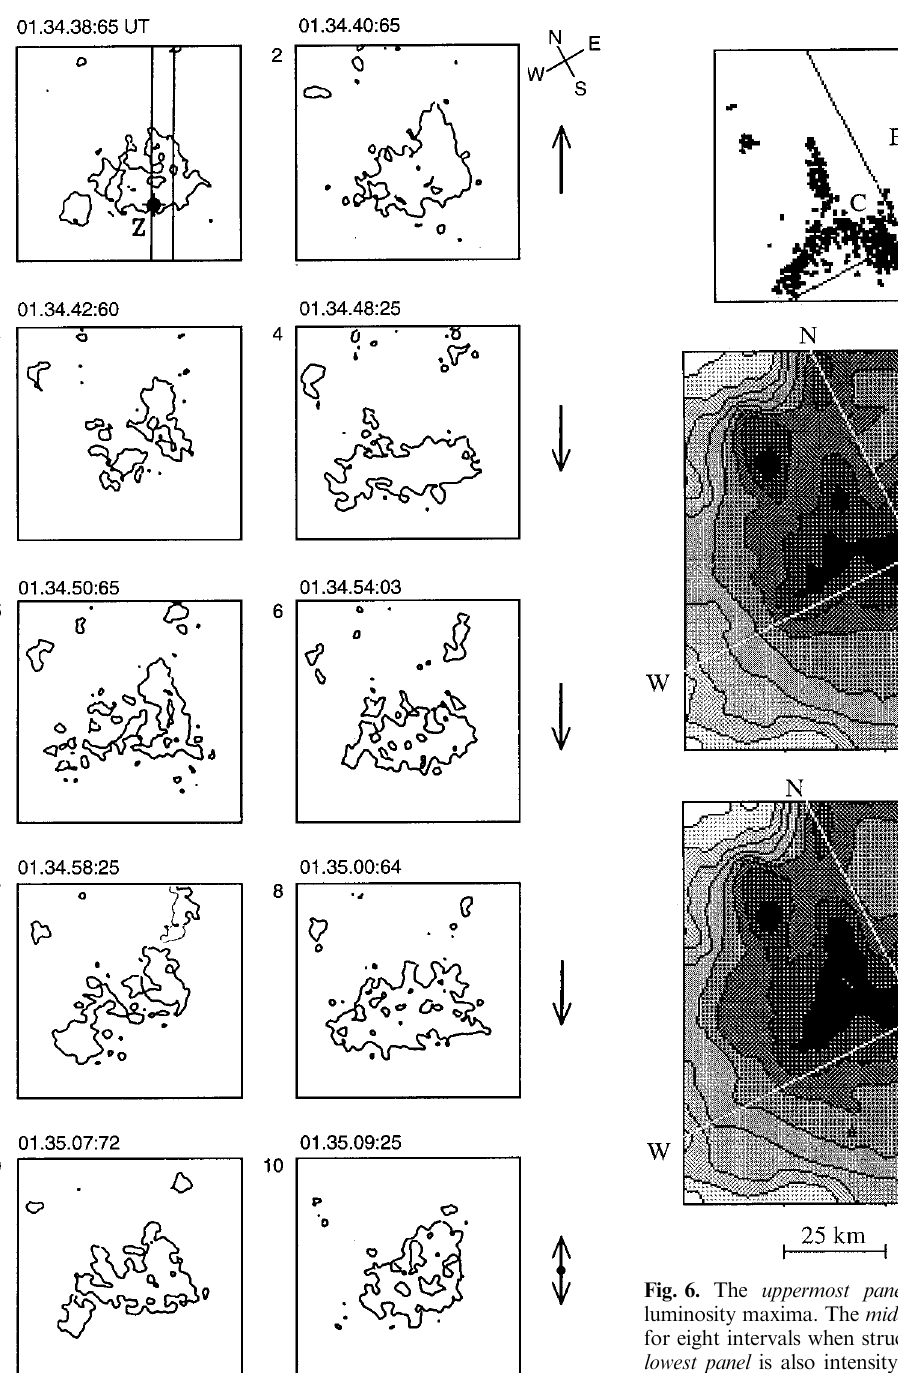
Fig. 5. The contours of the auroral patch for the moments indicated by triangles below the horizontal axis of the second panel in Fig. 4. The keogram direction is shown by lines in the first square . Z means zenith. The contours were drawn at level of 80% of maximum luminosity in the interval